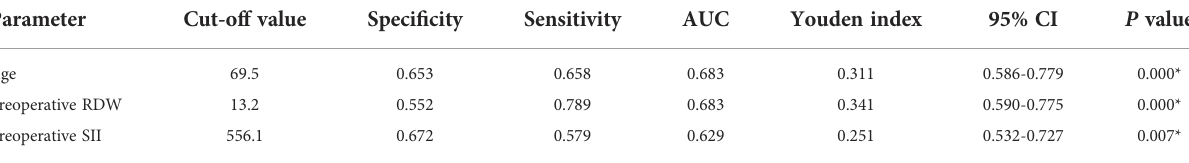
TABLE 7 Cut-off value for age, preoperative RDW, and preoperative SII for predicting postoperative pulmonary complications. Parameter